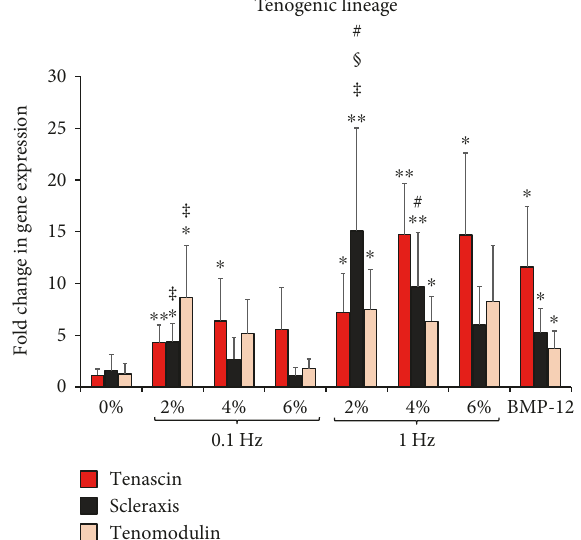
Figure 6: E ff ect of uniaxial tensile loading on tenogenic gene expression of ASCs encapsulated within 3D collagen sca ff olds. Gene expression pro fi les of ASCs encapsulated within collagen sca ff olds subjected to BMP-12 treatment or uniaxial loading at 0% (unloaded), 2%, 4%, and 6% strains at 0.1Hz and 1 Hz loading frequencies. The graph depicts fold changes in various tenogenic markers: tenascin-C, scleraxis, and tenomodulin. ∗ indicates signi fi cant fold increase with respect to the 0% samples. ∗ indicates p < 0 05 , ∗∗ denotes p < 0 01 . ‡ is the statistical di ff erence with respect to 6% group, both with a 95% con fi dence interval. # represents a signi fi cant di ff erence between 0.1Hz and 1 Hz groups at the same magnitude of strain with p < 0 05 . § depicts signi fi cant di ff erence with respect to unloaded samples chemically stimulated with BMP-12 with p < 0 05 . Samples stimulated with 2% strain at both 0.1 Hz and 1Hz show increased levels of all three tenogenic markers.